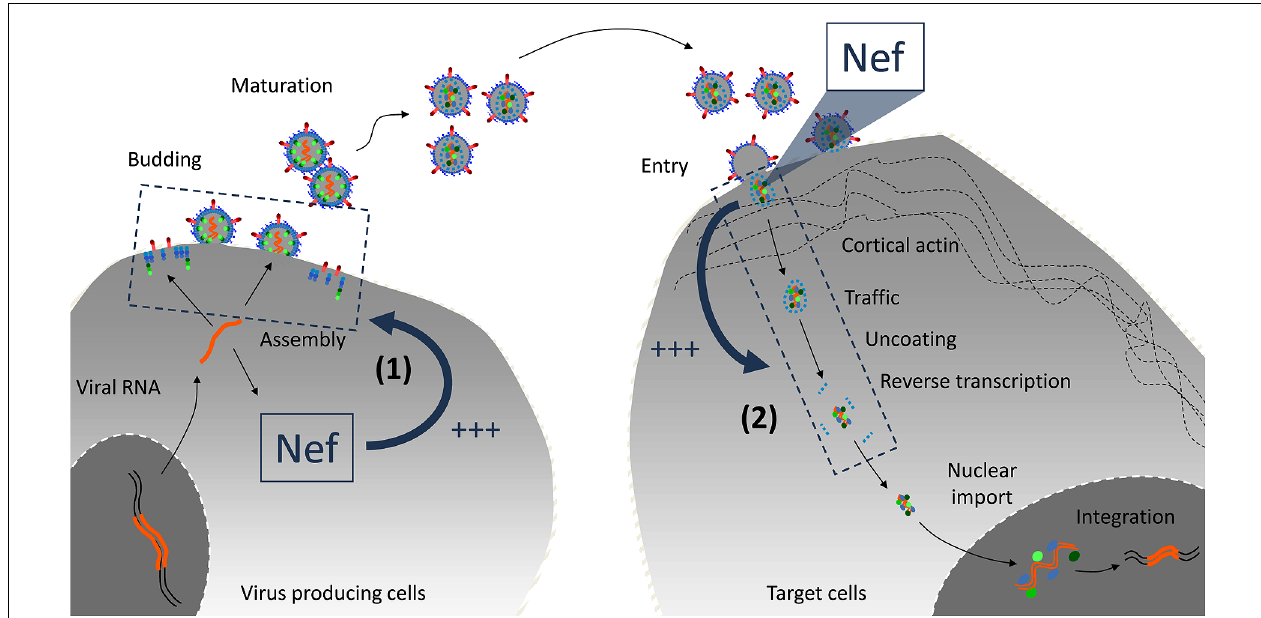
FIGURE 1 | Cellular or virus-borne: localization of Nef activity on virus infectivity. Nef is expressed in infected cells and incorporated into virions. Given the profound imprint of Nef on the biology of infected cells, it may regulate a cellular function in virus-producing cells that favors virus